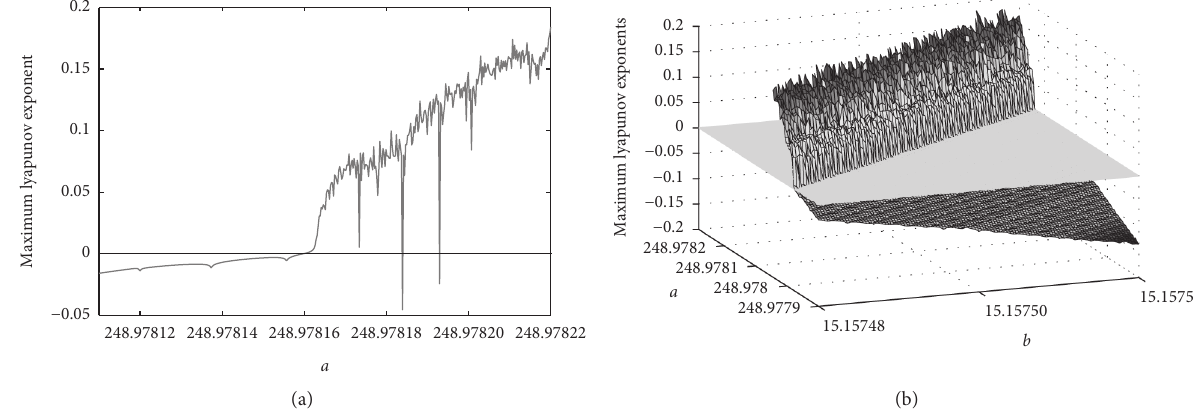
Figure 5: Maximum Lyapunov exponents of map (2) near (0.61636576, 0.605198) as a and b varying: (a) in ( a − MLE ) plane with b � 15 . 1575017 and (b) in ( b − a − MLE ) space.